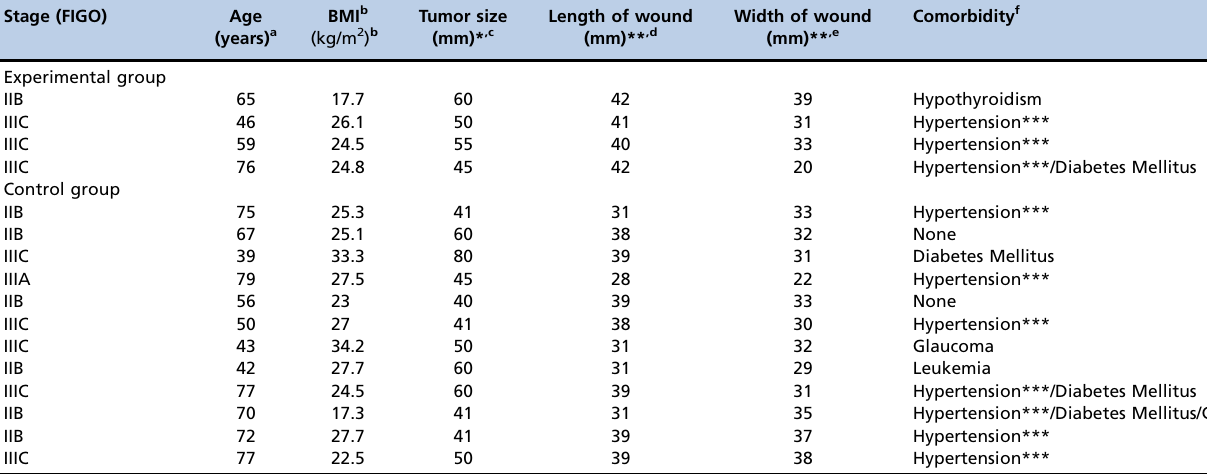
Table 1 - Clinical features of the patients. Stage (FIGO)